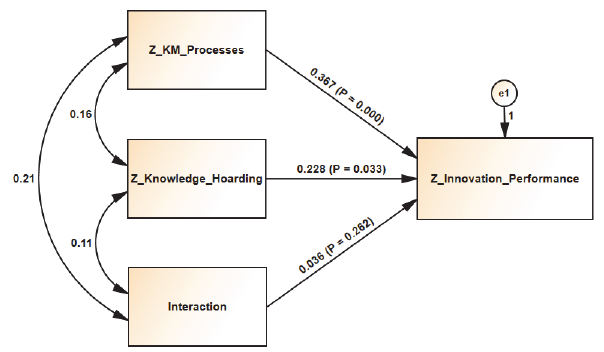
Fig. 3. Hypothesis testing